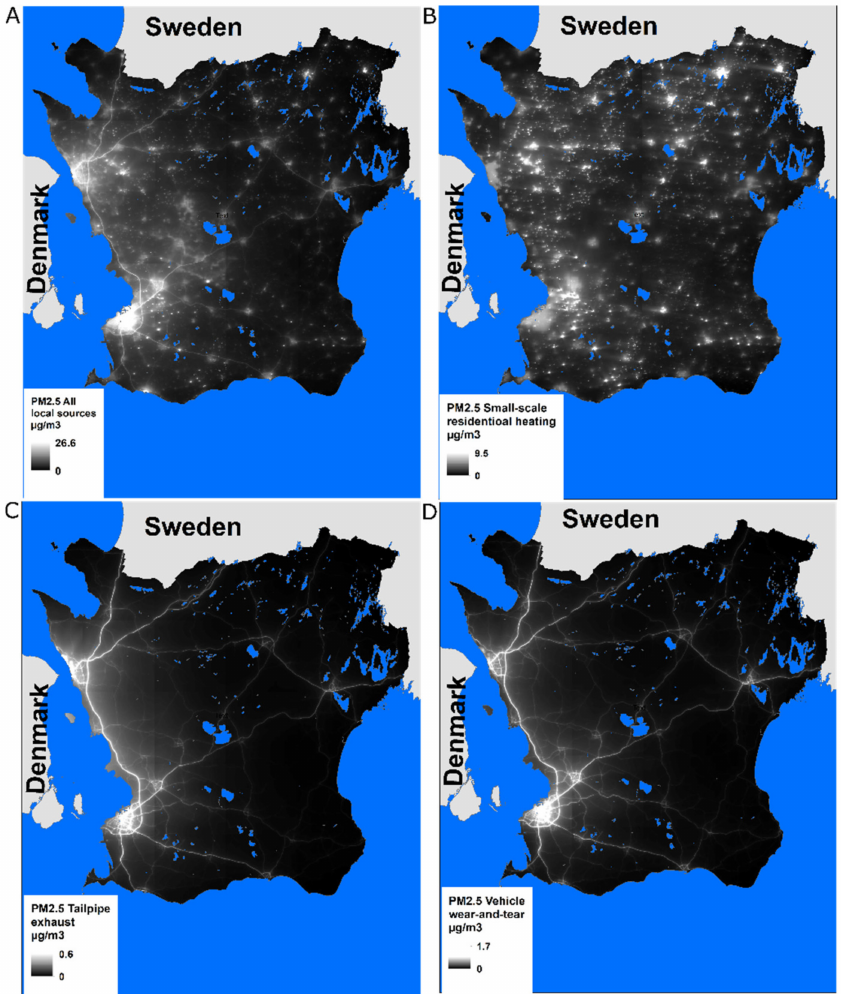
Figure 2. Annual mean PM 2.5 concentrations from ( A ) all local sources, ( B ) small-scale residential heating, ( C ) tailpipe exhaust, and ( D ) vehicle wear-and-tear in µ g/m 3